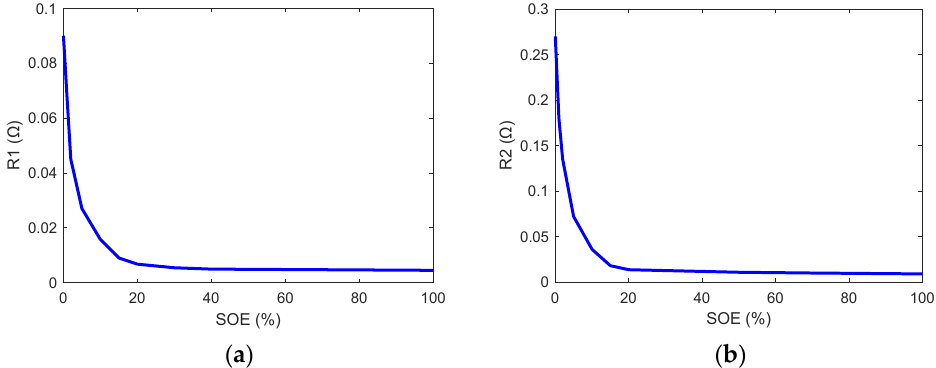
Figure 5. Polarization resistance at − 20 °C . ( a ) Activation polarization resistance; ( b ) concentration polarization resistance.